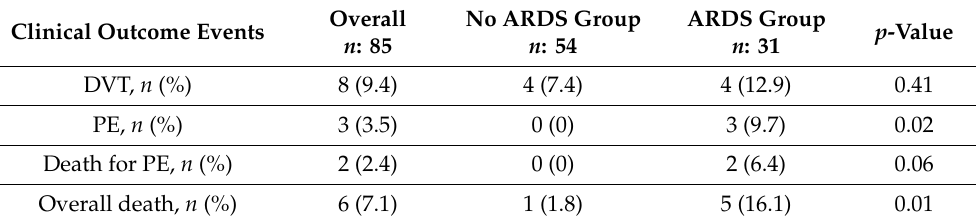
Table 6. Numbers and rates of clinical outcome events in the study population.